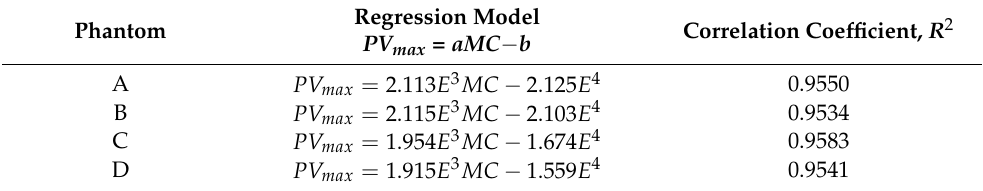
Table 6. Correlation coefficients of the regression model using NOSER algorithm.